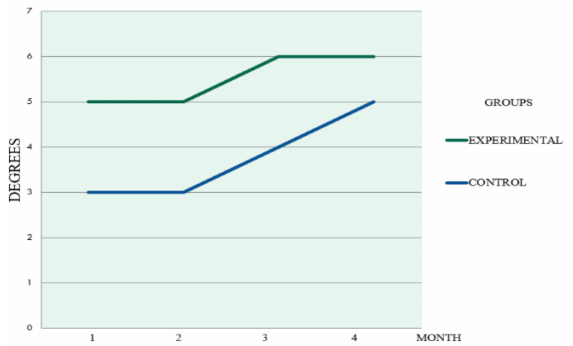
Figure 4. Monthly Ro/BR average post-extraction comparing EG and